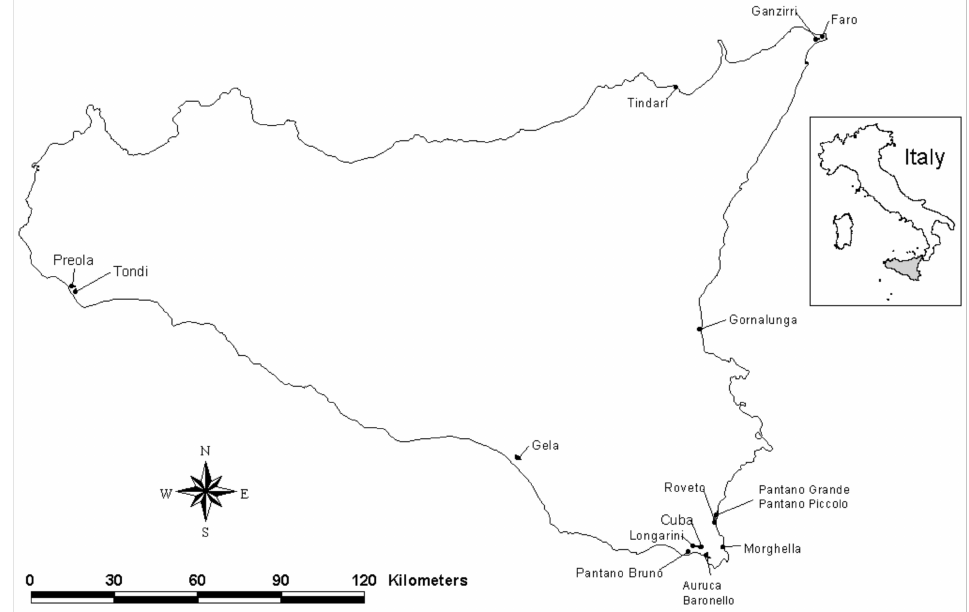
Figure 1. The Sicilian wetlands under study (Italy). Wetlands are marked with arrows and